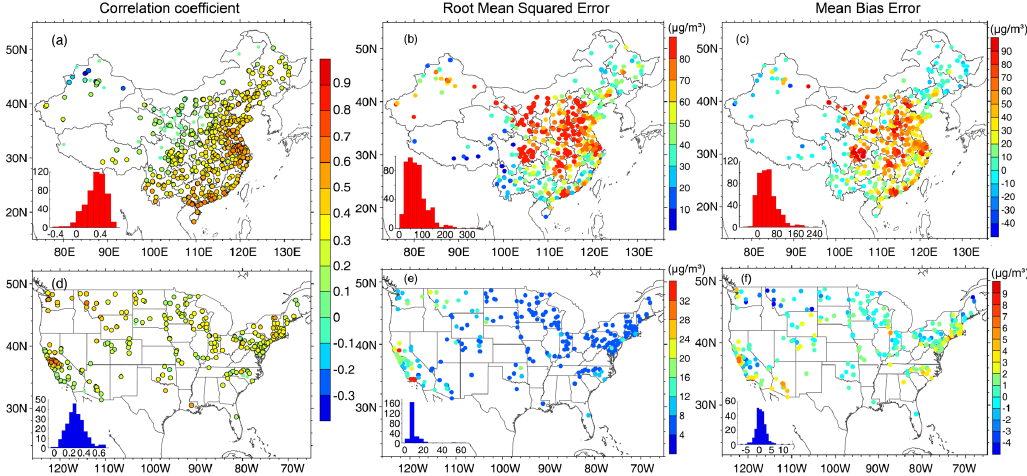
Figure 2. Data accuracy of PM 2.5 forecasts from the the European Copernicus Atmosphere Monitoring Service (CAMS) with a forecasting time horizon of 120 h (step-120) in China ( a – c ) and United States (US) ( d – f ). Dots with a black edge in ( a , d ) imply correlations were statistically significant at the 95% confidence